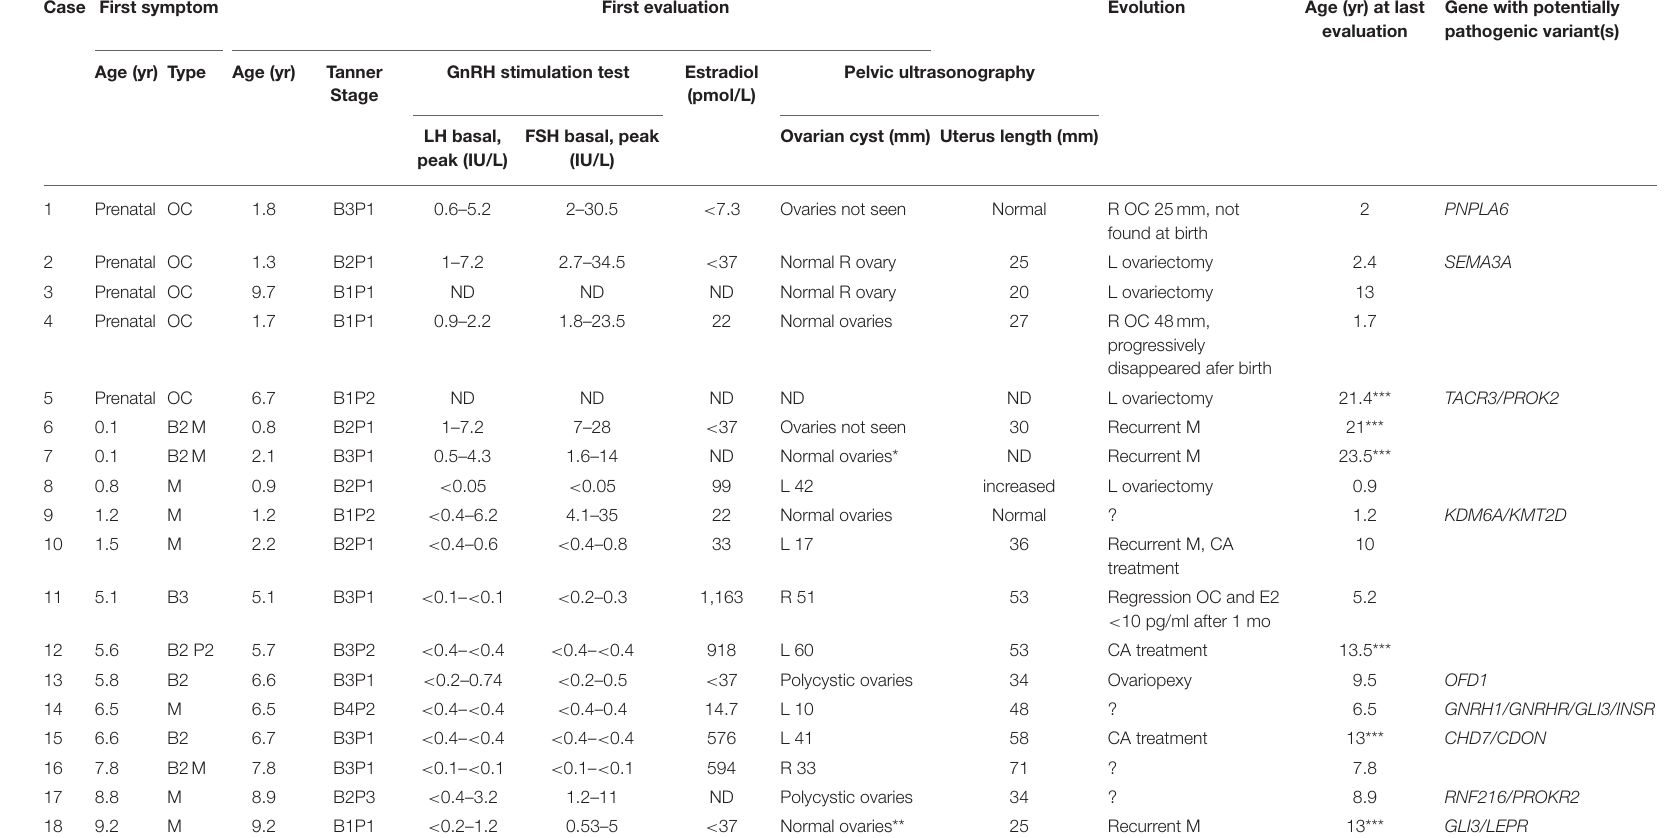
TABLE 1 | Clinical, biological, ultrasonographic data, and evolution of 18 girls with prepubertal ovarian cyst. Case First